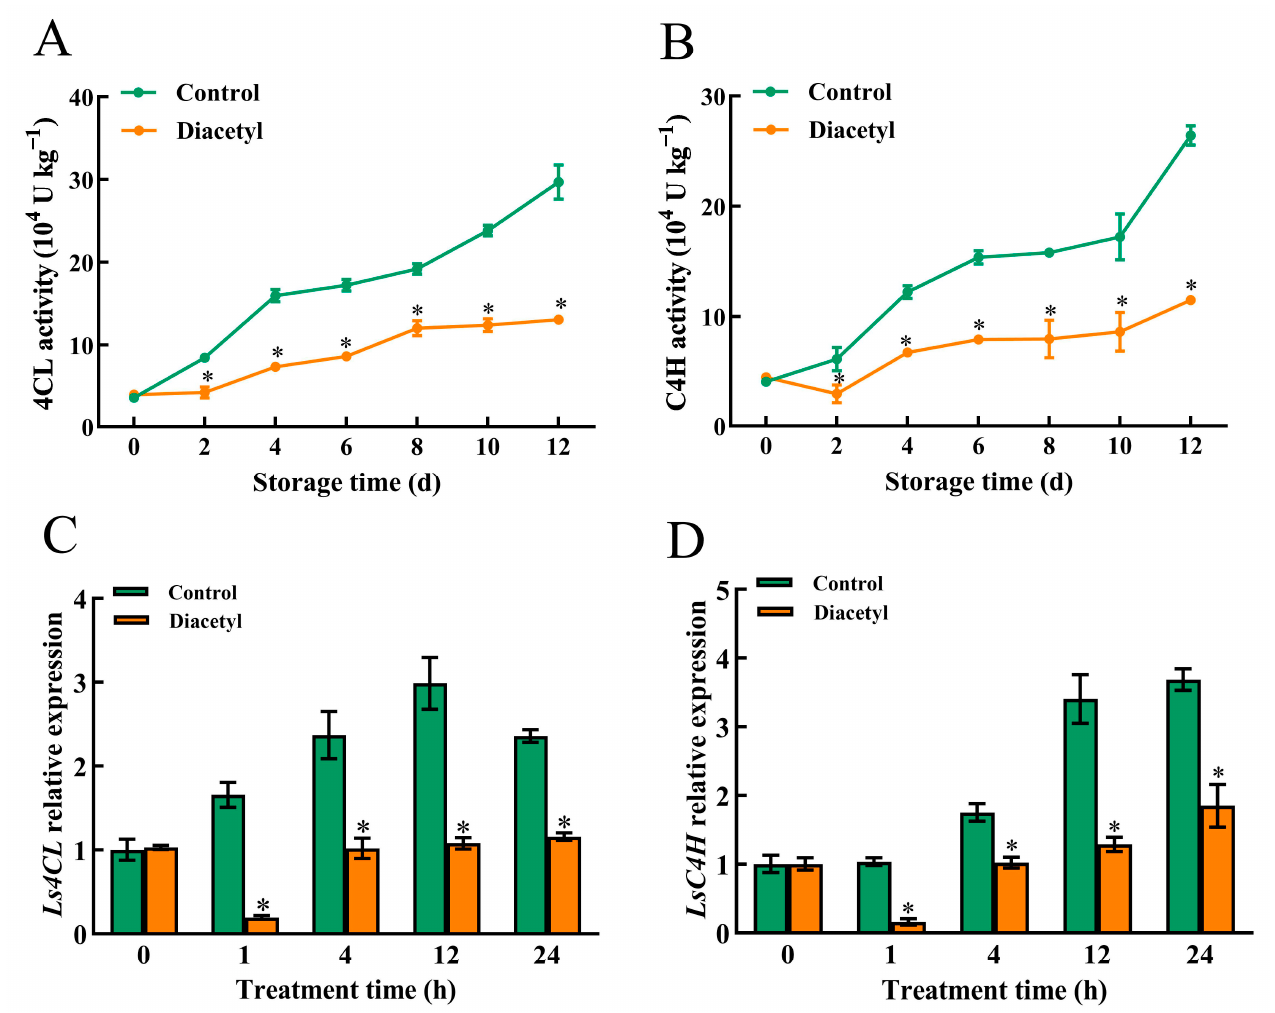
Figure 4. Diacetyl reduced the activities and gene expressions of 4CL and C4H. 4CL activity ( A ), C4H activity ( B ), the gene expressions of Ls4CL ( C ) and LsC4H ( D ) of fresh-cut stem lettuce at 4 °C. Asterisks * indicate the significant differences ( p < 0.05) between control and treated groups in the figure at the same storage time. Vertical bars represent standard deviations.